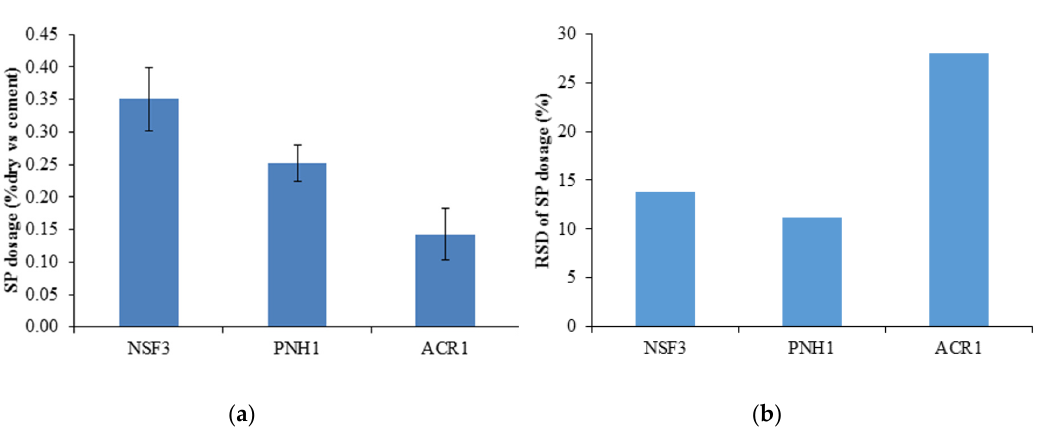
Figure 2. Mean value ( a ) and RSD ( b ) of the superplasticizer dosage (% of dry polymer vs. cement mass) to attain 220–230 mm slump on concrete.